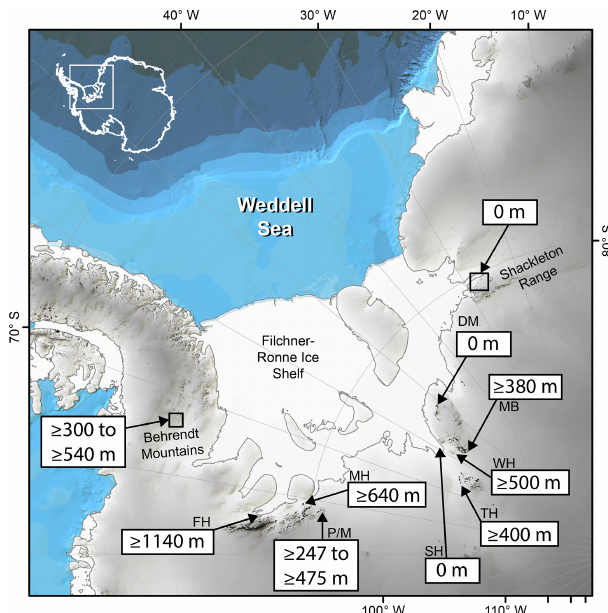
Figure 2. Current terrestrial ice thickness constraints inferred from measurements of long-lived nuclides around the WSE. Acronyms are as in Fig. 1. Constraints for the SH, WH, and TH are sourced from Balco et al. (2016) and Bentley et al. (2017). MB is Mount Bragg (Bentley et al., 2017). Thickness estimate for the Dufek Mas- sif (DM) is sourced from Hodgson et al. (2012). Constraints for the P/M are sourced from Hein et al. (2016). For the MH and FH, the LGM thickness constraints are sourced from Fogwill et al. (2014). The thickness constraints sourced from Fogwill et al. (2014) were interpreted using modern ice surface elevations for the Rutford Ice Stream and Union Glacier measured using the Reference Elevation Model of Antarctica (REMA; Howat et al., 2019). Thickness con- straints for the Shackleton Range are sourced from Hein et al. (2011, 2014). The range of LGM thicknesses for the Behrendt Mountains are sourced from multiple locations (Bentley et al.,